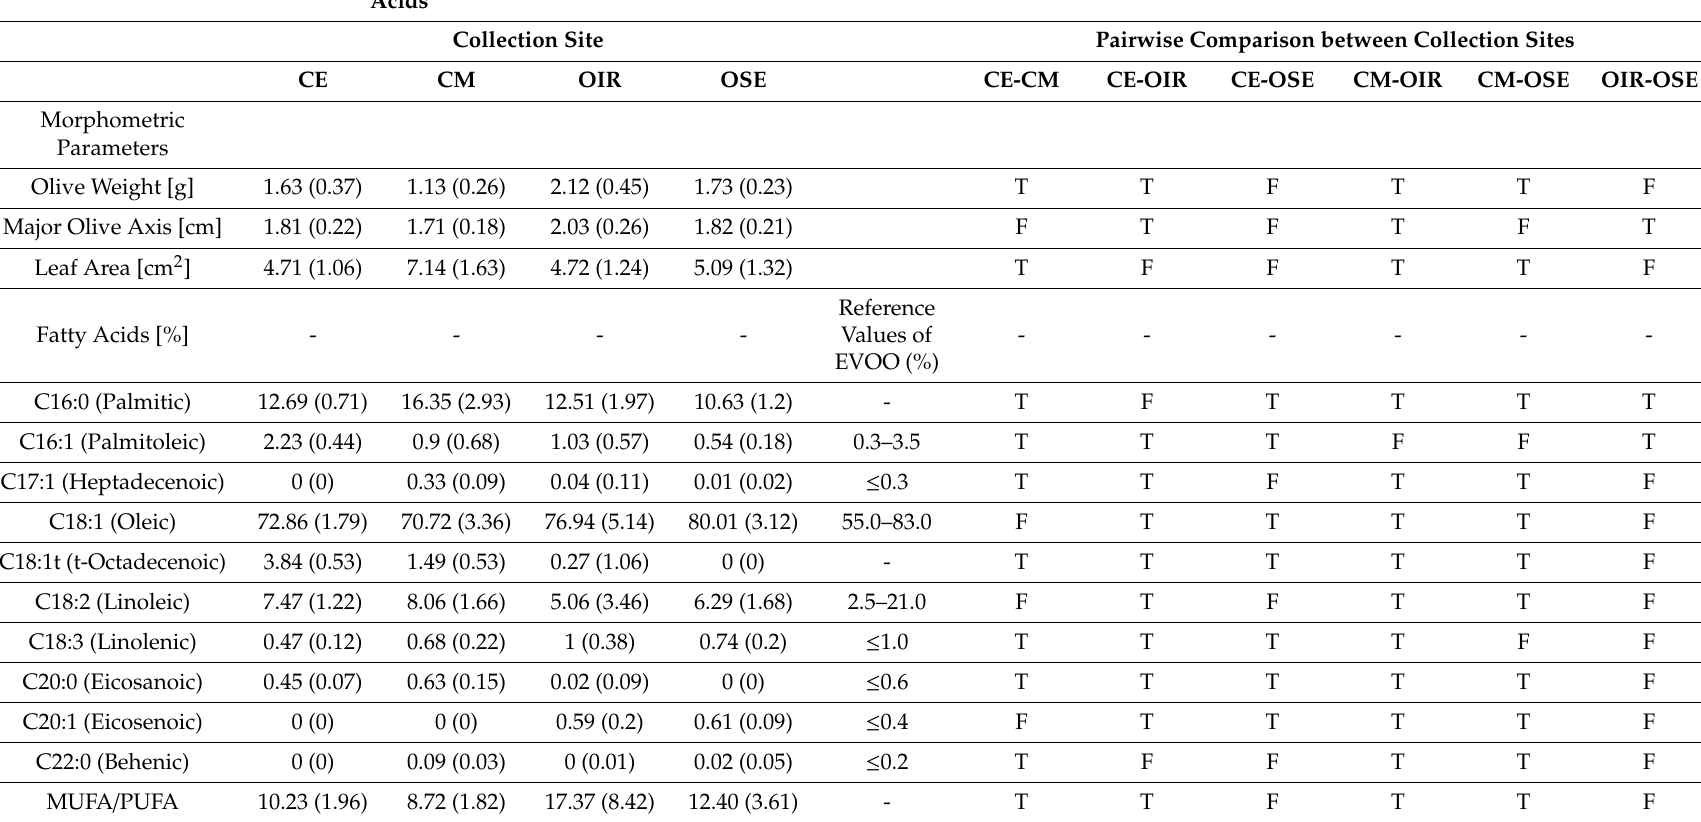
Table 1. Mean values and standard deviation of morphometric parameters and fatty acids concentration divided for the four collection sites (left) and results of the Kruskal–Wallis post-hoc test (right) with multiple comparison test for every measured parameter. Significant di ff erences between pairs of groups are represented by the T (TRUE); non-significant di ff erences are represented by the F (False). Mean Values and Standard Deviation of Morphometric Parameters and